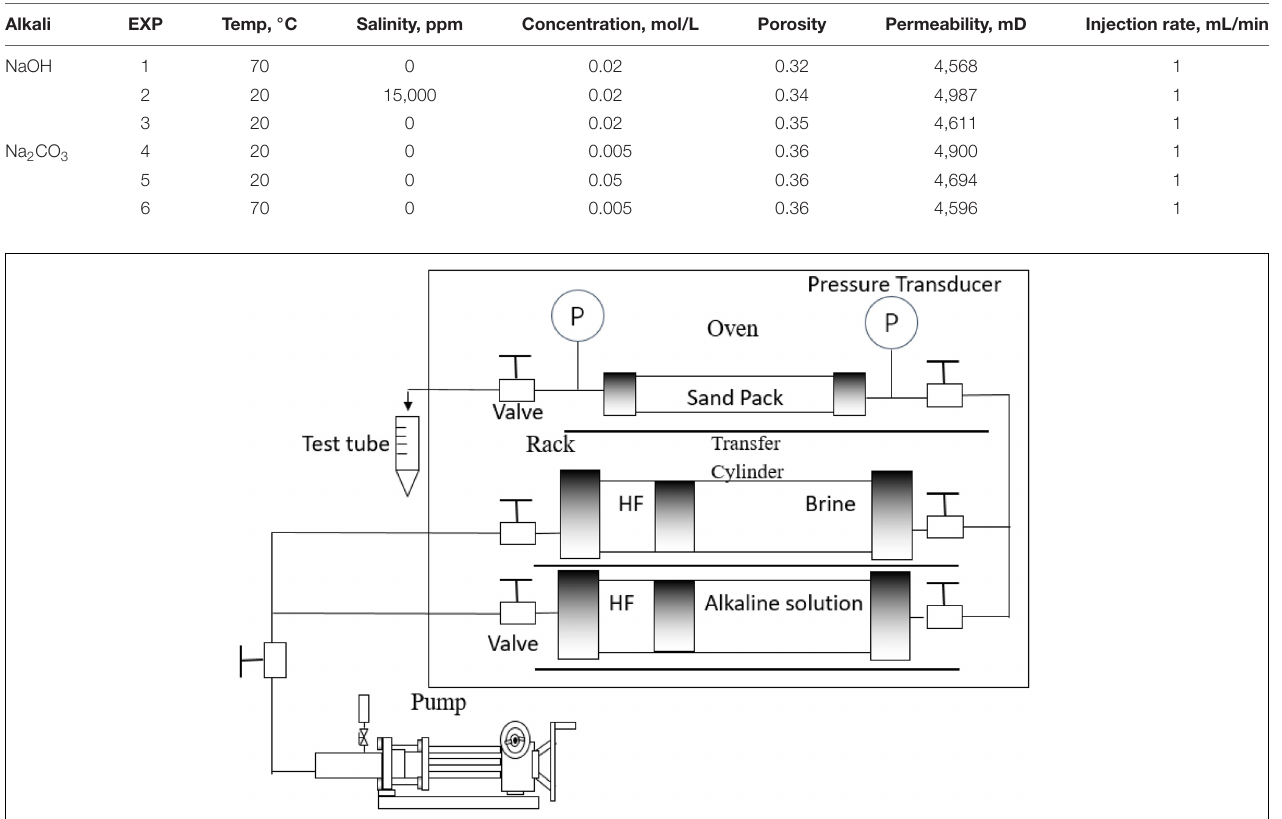
FIGURE 10 | Schematic diagram of sandpack alkaline flooding test.